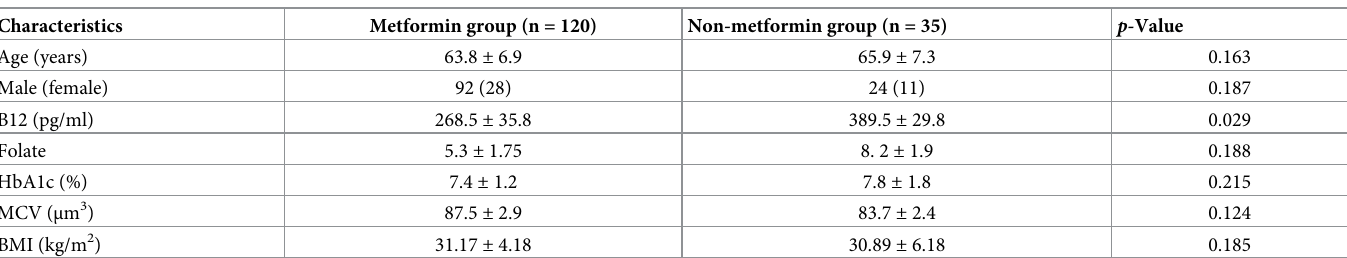
Table 1. Demographic data of